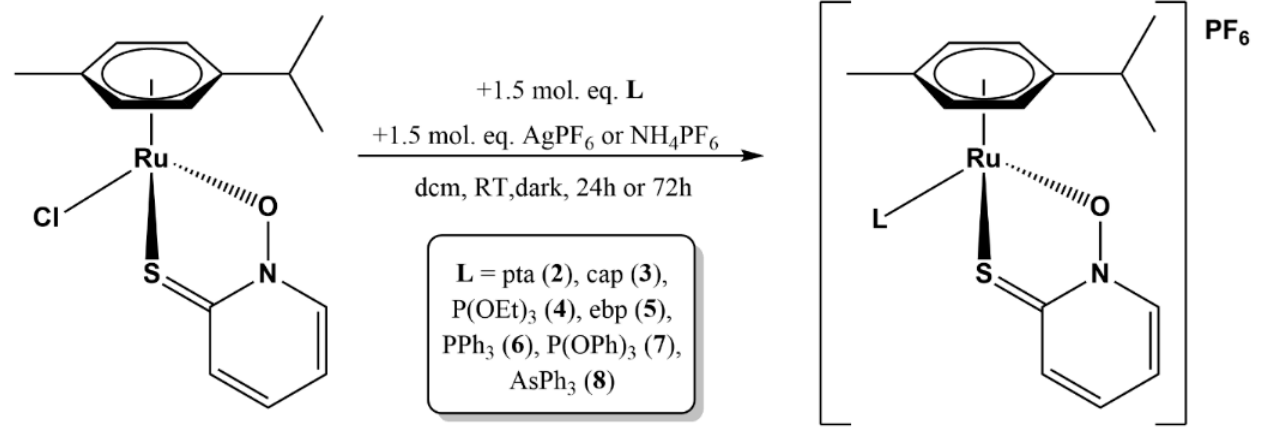
Figure 3. General reaction scheme for preparation of ruthenium–pyrithionato complexes 2 – 8 with different phosphine, phosphite, or arsine ligands.